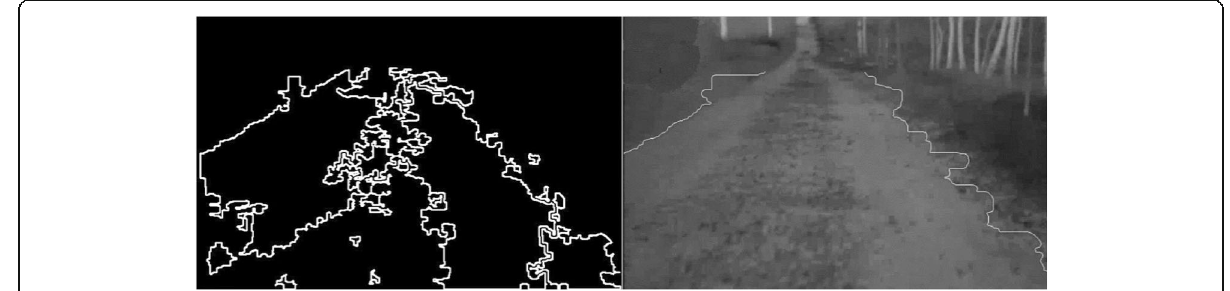
Fig. 20 DBSCAN clustering and road boundary recognition. a Clustering result. b Road boundary recognition